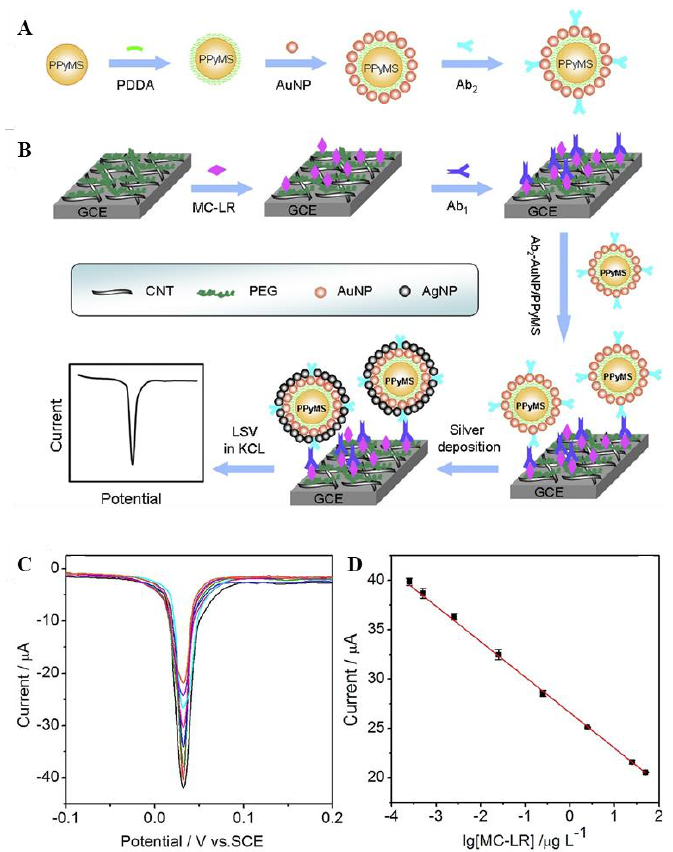
Figure 1. ( A ) Ab2-AuNP/PPyMS particle preparation method. ( B ) Schematic representation of the MC-LR immunosensor fabrication and competition immunoassay procedure. ( C ) Linear sweep stripping voltammetry curves of silver nanoparticles deposited on the immunosensors at 1.0 M KCl after incubation with the lowest peak currents in the MCLR having corresponding concentration ranges (0.00025, 0.0005, 0.0025, 0.025 , 0.25, 2.5, 25, and 50 μg /L). ( D ) Calibration curve for MC-LR immunoassay. Reproduced with permission from [56], published by Elsevier, 2017.